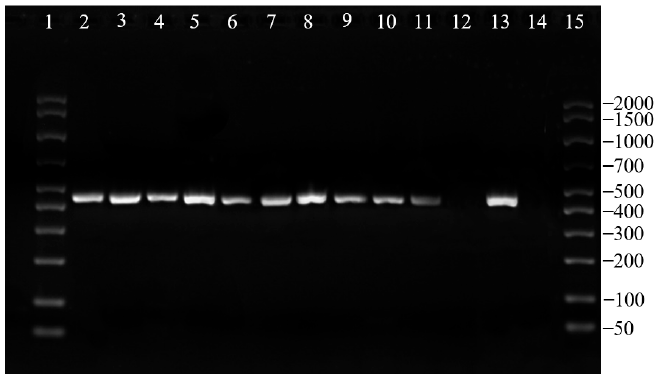
Figure 3. Results of the PCR performed on part of the found parasites. Lane 1 and 15: molecular weight marker (AmpliSize Molecular Ruler 50–2000 bp, Bio-Rad, Italy). Lane 2 to 11: DNA of parasites analyzed in the study. Lane 12: negative extraction control. Lane 13: positive PCR control. Lane 14: negative PCR control.